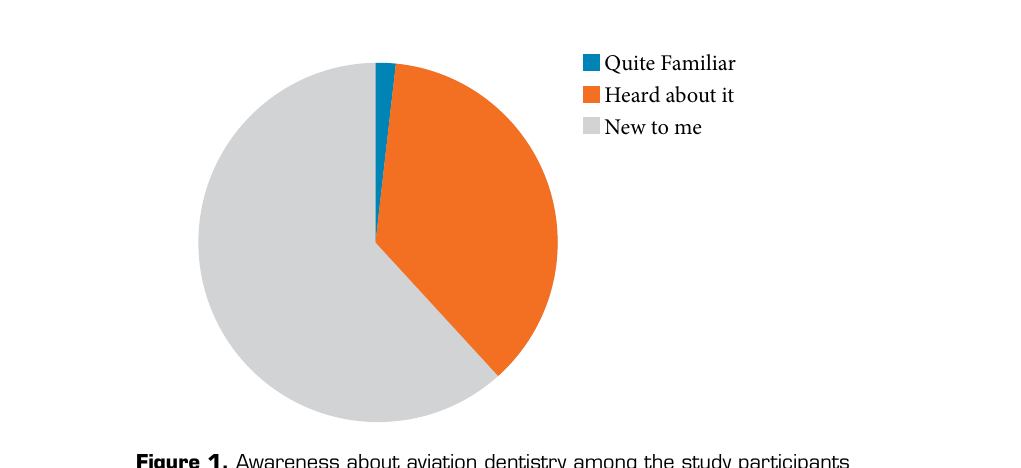
Figure 1. Awareness about aviation dentistry among the study participants Table 2. Familiarity with the terms and responses to the questions by the study